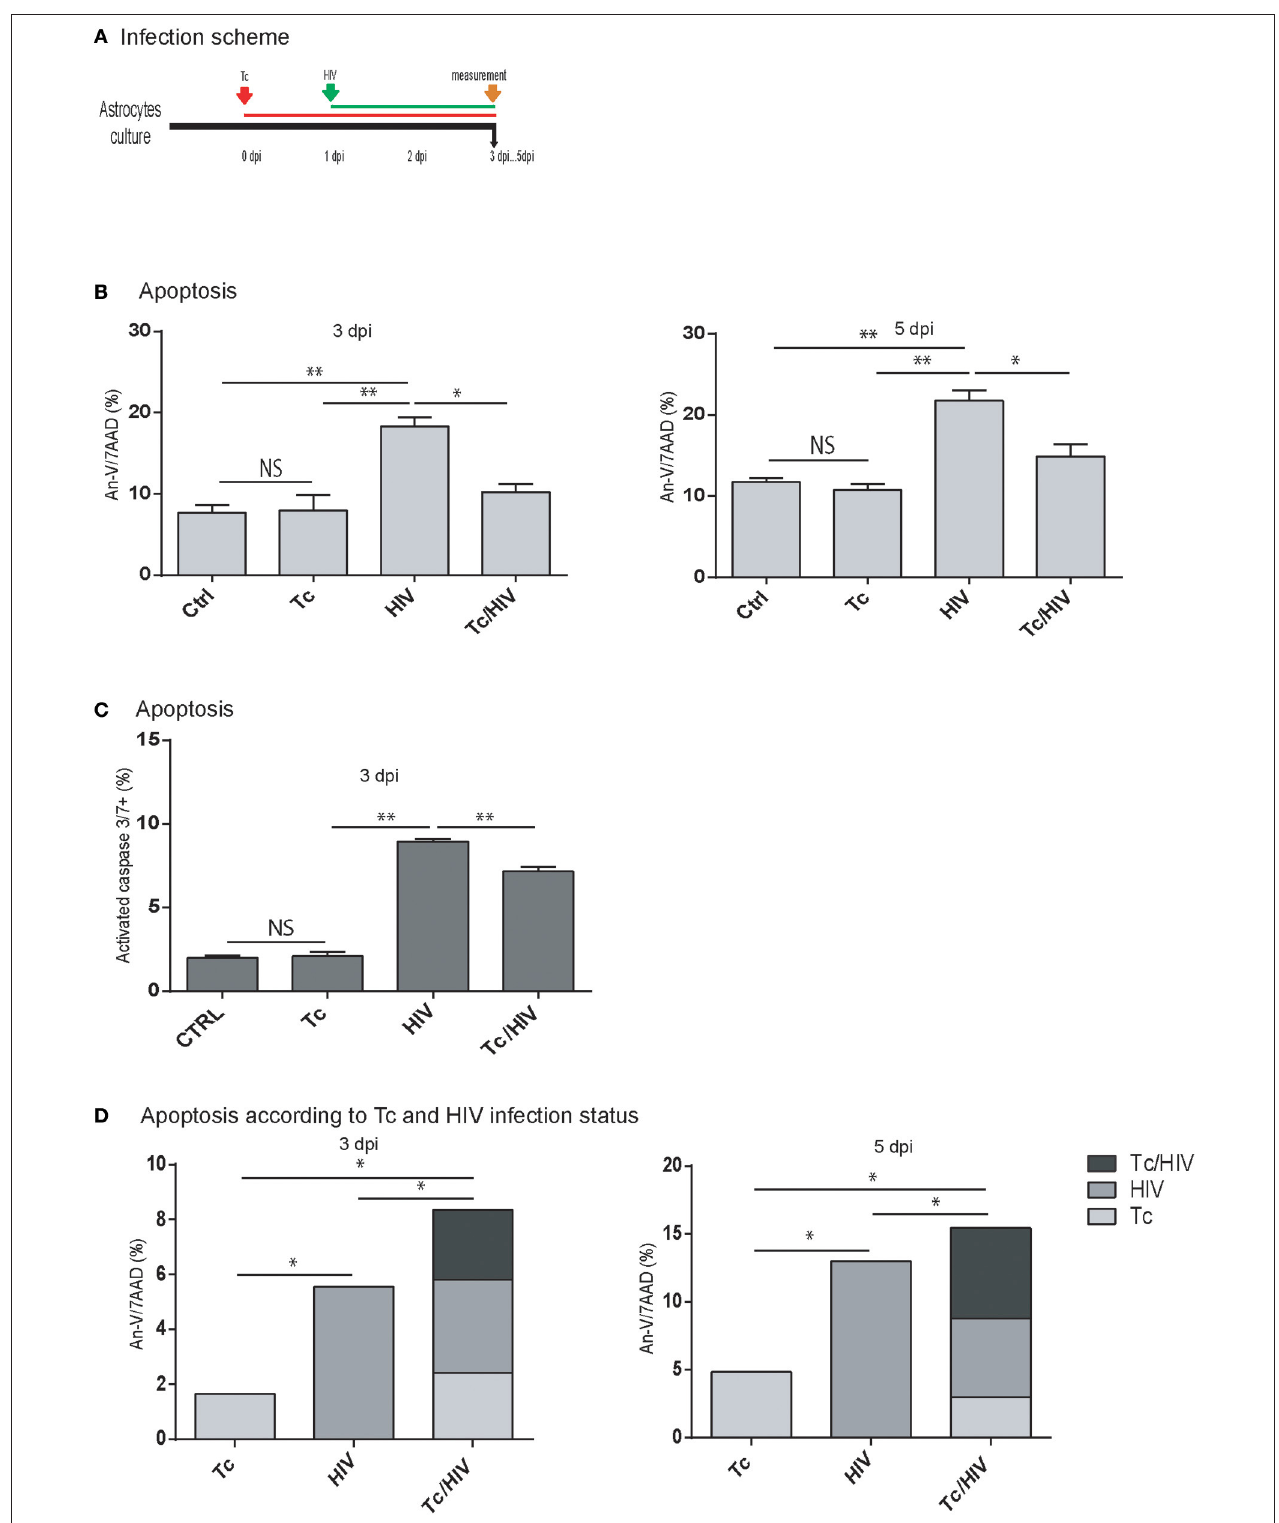
FIGURE 2 | Apoptosis of astrocytes after Trypanosoma cruzi and HIV exposure. (A) Infection timeline (B) Flow cytometric apoptosis assay (Annexin V/7AAD) on astrocytes upon exposure to Tc, HIV, or combination (Tc/HIV). Percentage of apoptotic cells at 3 and 5 dpi is shown. Mean values ± SD from three different experiments. Statistical significance for each condition vs. pathogen unexposed control, or between conditions is indicated by asterisk(s). Two-tailed paired Student